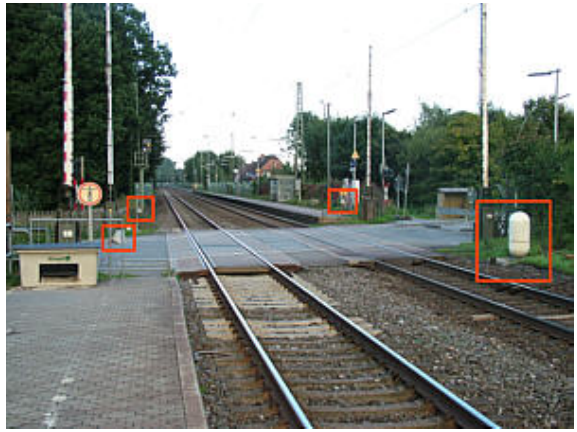
Figure 5. Level Crossing with Vehicular Detectors